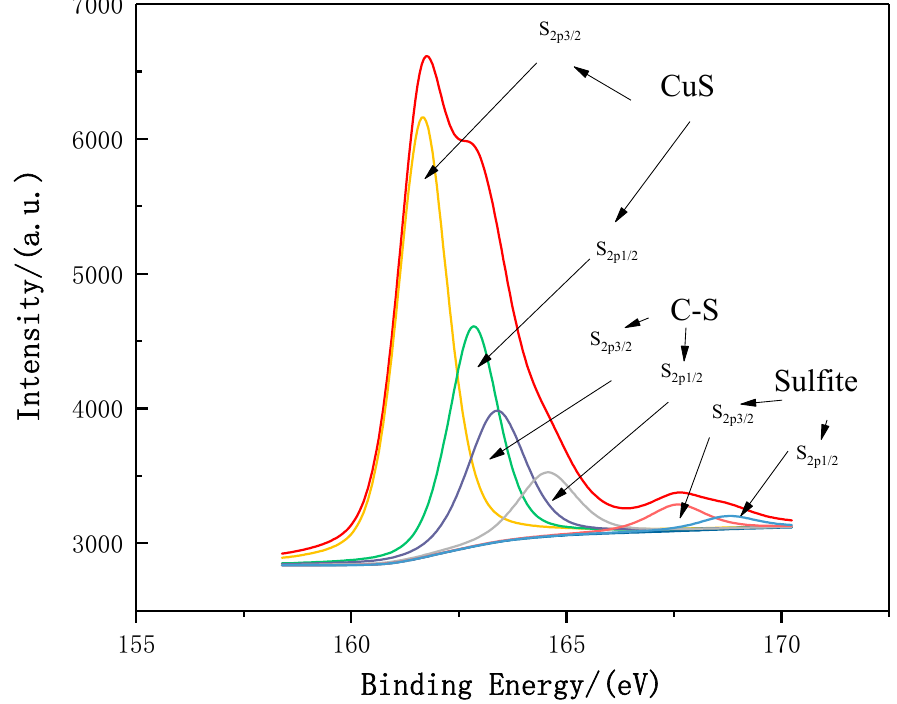
Figure 9. The XPS spectrum of S in hydrochar S5C5 after H 2 S adsorption.